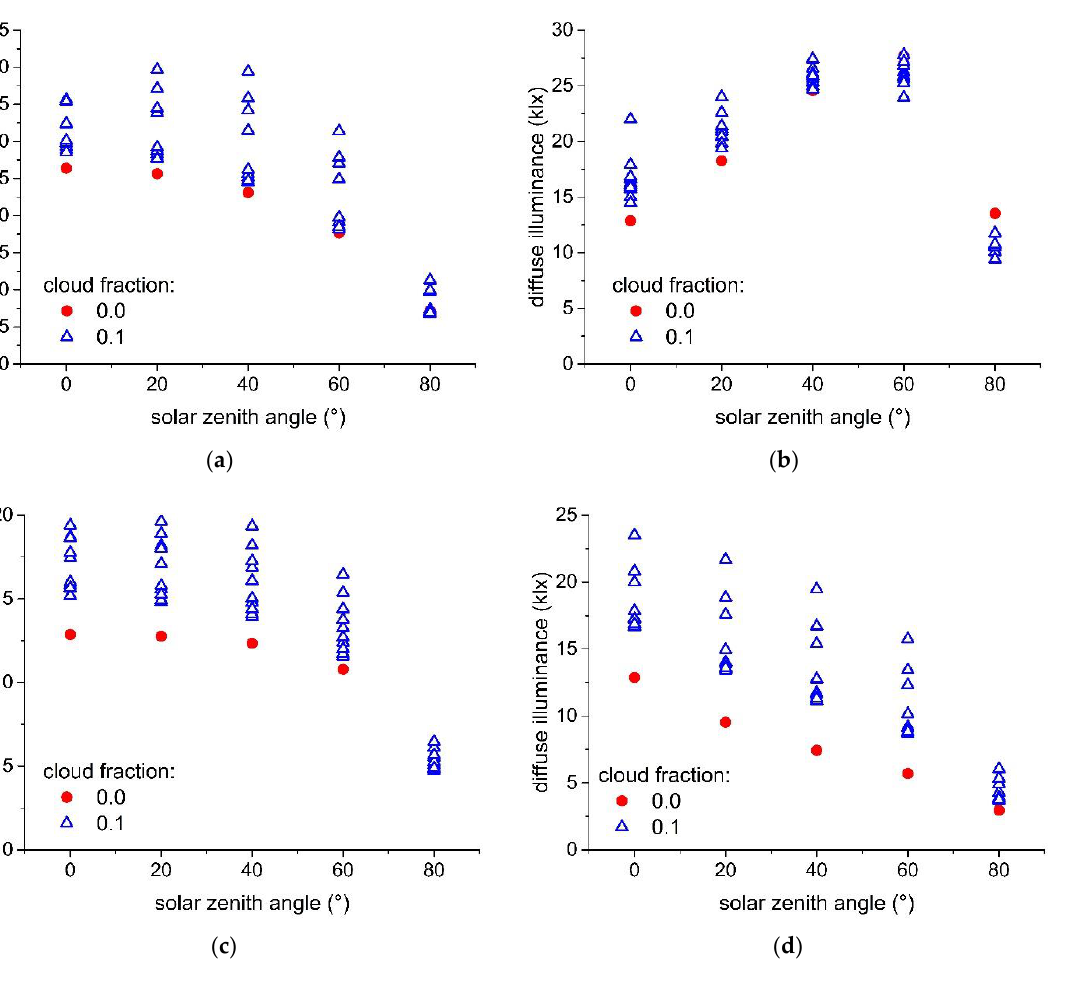
( d ) Figure 3. Diffuse illuminance on the horizontal plane ( a ) and vertical planes oriented to the south ( b ), east ( c ), and north ( d ) as a function of the solar zenith angle calculated for ten random distributions of identical clouds with the cloud frac- tion equal to 0.5.